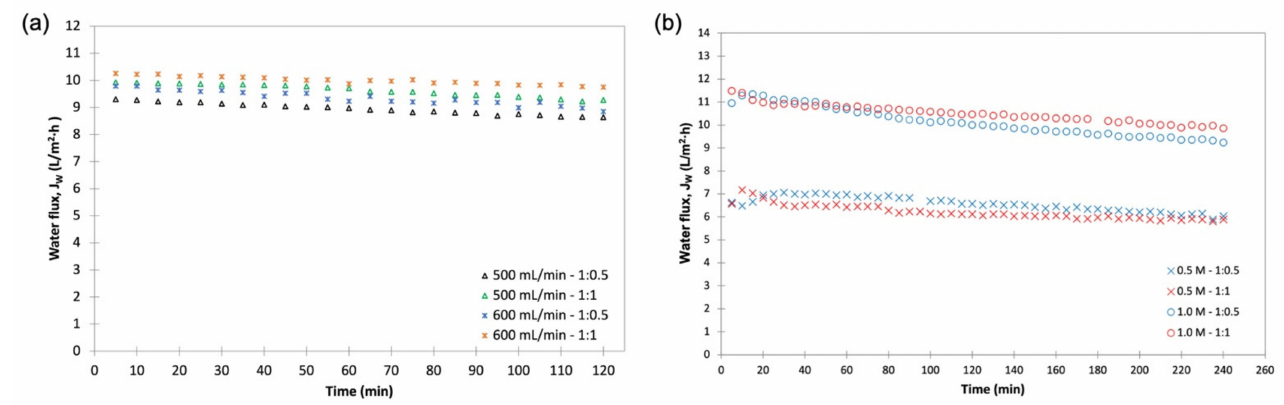
Figure 4. Pure water flux, J W , behaviors for ( a ) 1M NaCl, varying flowrate and FS:DS volume ratio (500 mL/min with a volume ratio of 1:0.5; 500 mL/min with a volume ratio of 1:1; 600 mL/min with a volume ratio of 1:0.5; 600 mL/min with a volume ratio of 1:1); ( b ) flowrate at 600 mL/min, varying NaCl concentration and FS:DS volume ratio (0.5 M NaCl with a volume ratio of 1:0.5; 0.5 M NaCl with a volume ratio of 1:1; 1.0 M NaCl with a volume ratio of 1:0.5; 1.0 M NaCl with a volume ratio of